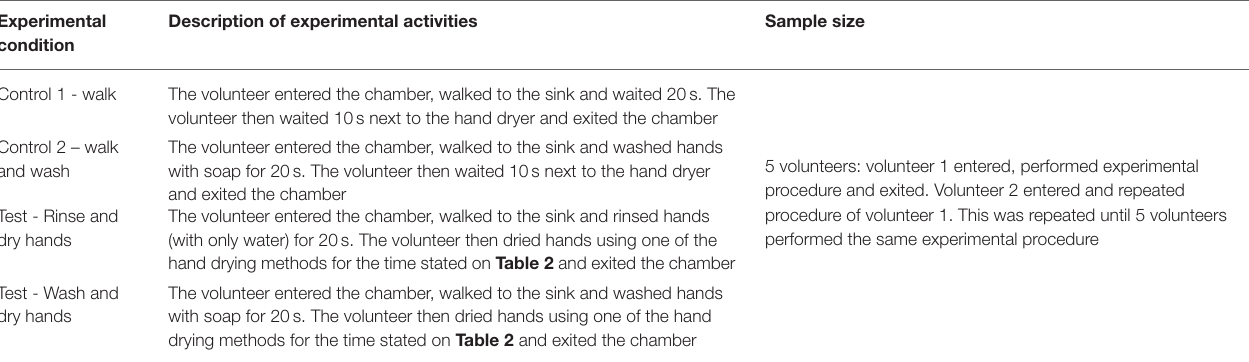
TABLE 1 | Description of experimental conditions and sample size for control and test (use of different hand drying methods) experiments. Experimental